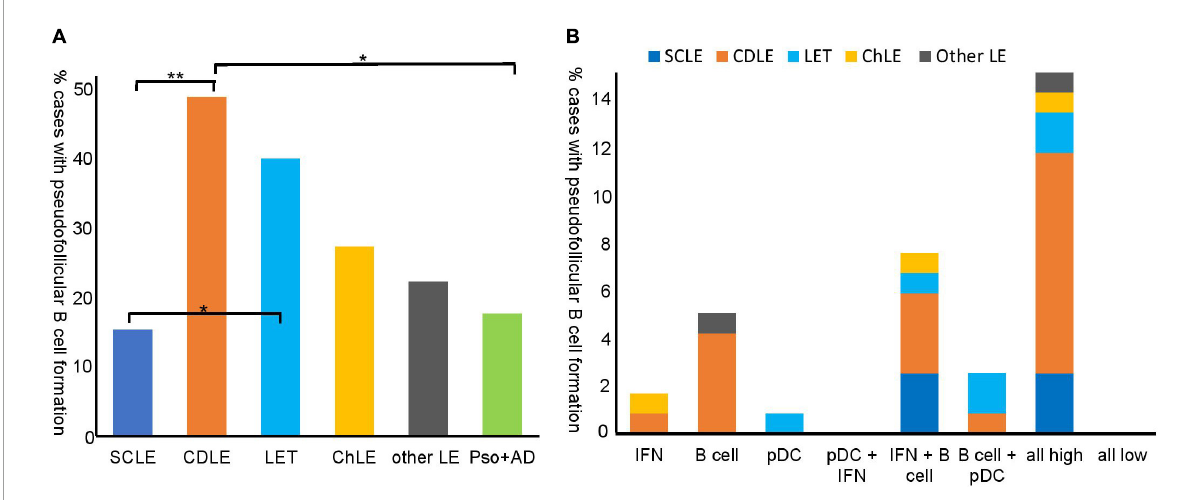
FIGURE3 Pseudofollicular B cell formation in different lupus erythematosus (LE) subtypes and inflammatory control skin samples (A) and pseudofollicular B cell formation in inflammatory expression groups (B) . (A) % cases with pseudofollicular B cell formation (not overall B cell infiltration) in the LE subtypes and controls is shown proportionally to number cases of the according subtype [ n = 39 subacute cutanous LE (SCLE), n = 45 chronic discoid LE (CDLE), n = 15 LE tumidus (LET), n = 11 chilblain LE (ChLE), n = 9 other LE and n = 17 inflammatory control samples (psoriasis, atopic dermatitis)]. Pseudofollicular B cell formation was defined as clustering of B cells within the inflammatory infiltrate. (B) % cases with pseudofollicular B cell formation proportionally to all LE cases ( n = 119) shown with regard to inflammatory expression groups that are introduced in Figure 2